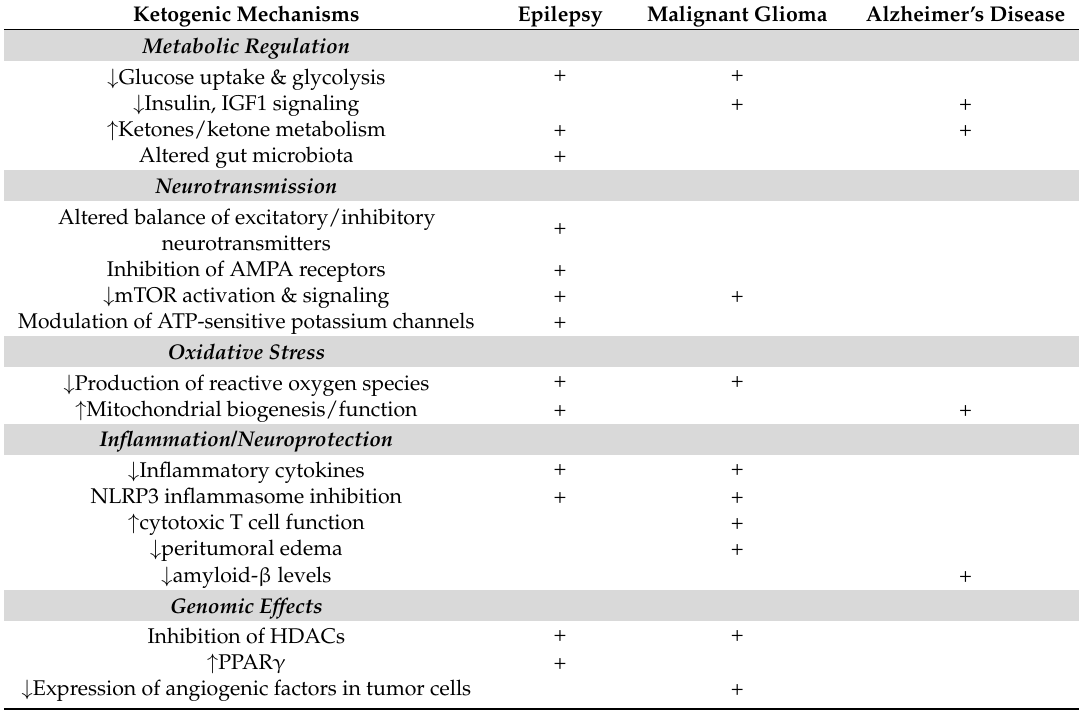
Table 1. Hypothesized mechanisms through which ketogenic therapies influence neurological disease. Ketogenic Mechanisms Epilepsy Malignant Glioma Alzheimer’s